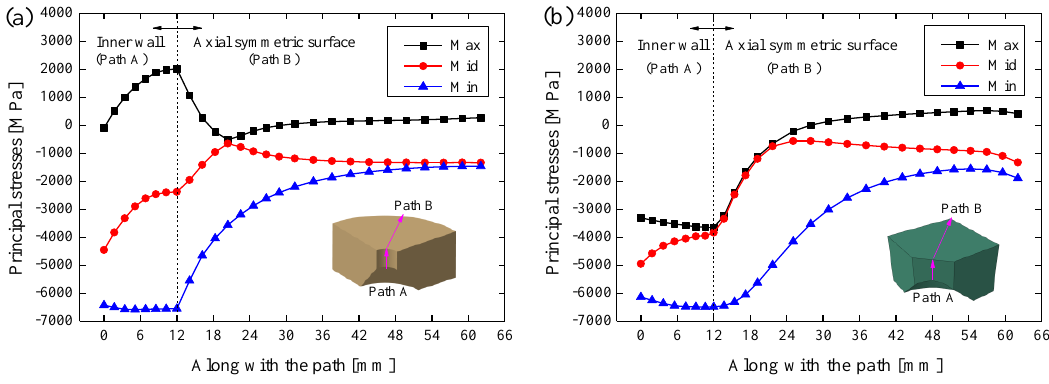
Figure 6. Principal stress distributions of cylinders: ( a ) BTD; and ( b ) DLSD.